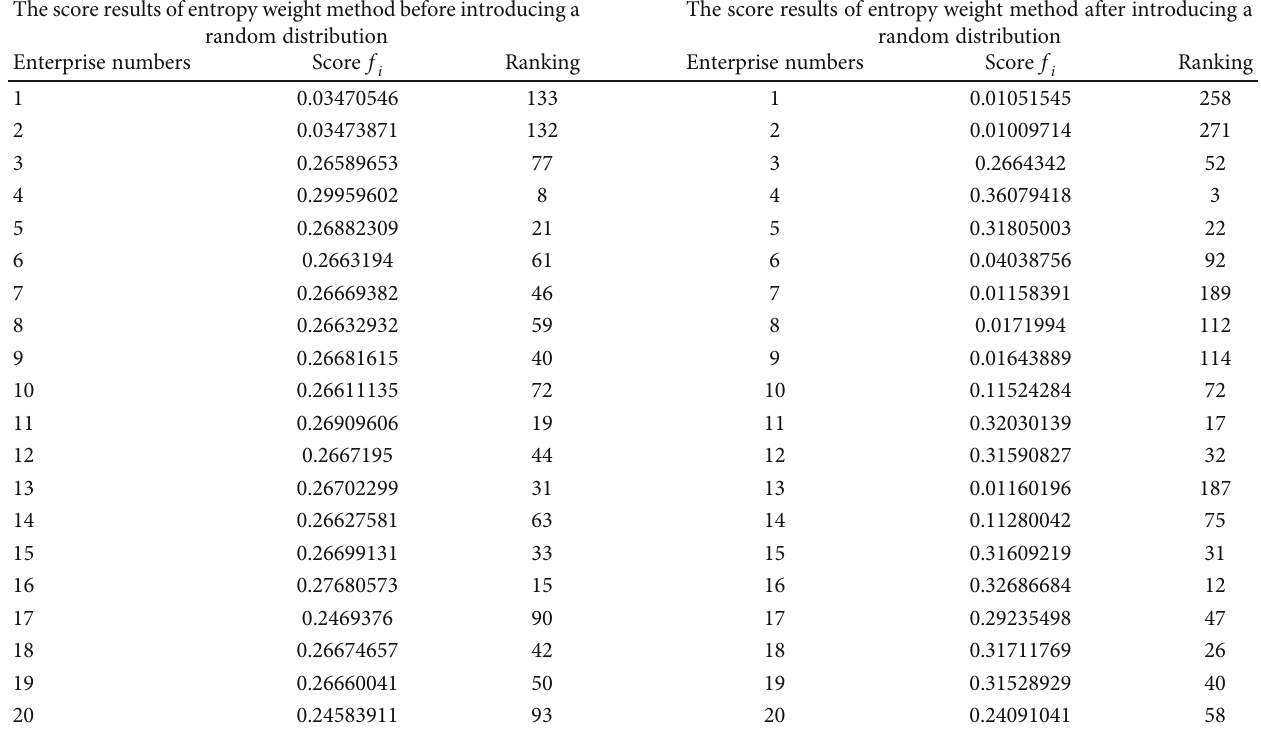
Table 2: Comparison of scores and rankings of the top 20 enterprises with enterprise numbers before and after the introduction of random distribution.